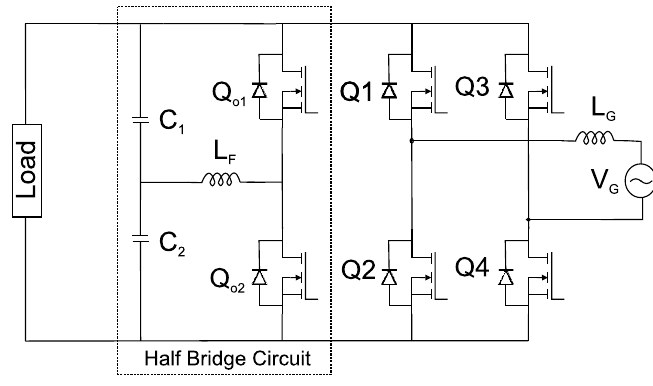
Figure 16. Symmetrical half-bridge configuration proposed in [93].